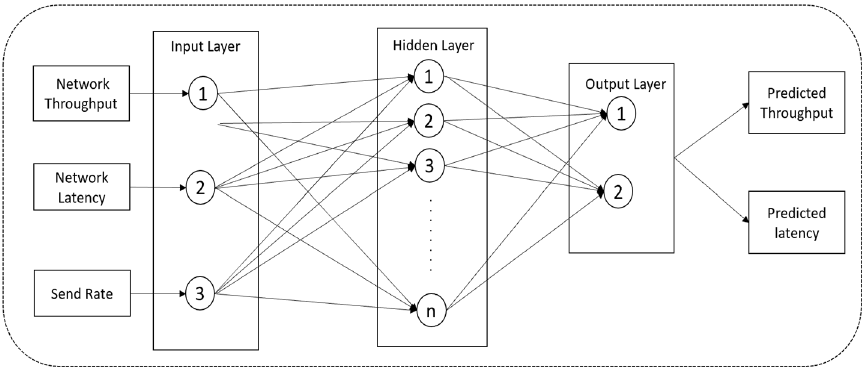
Figure 5. The detailed structure of the learn-to-predict ANN model.